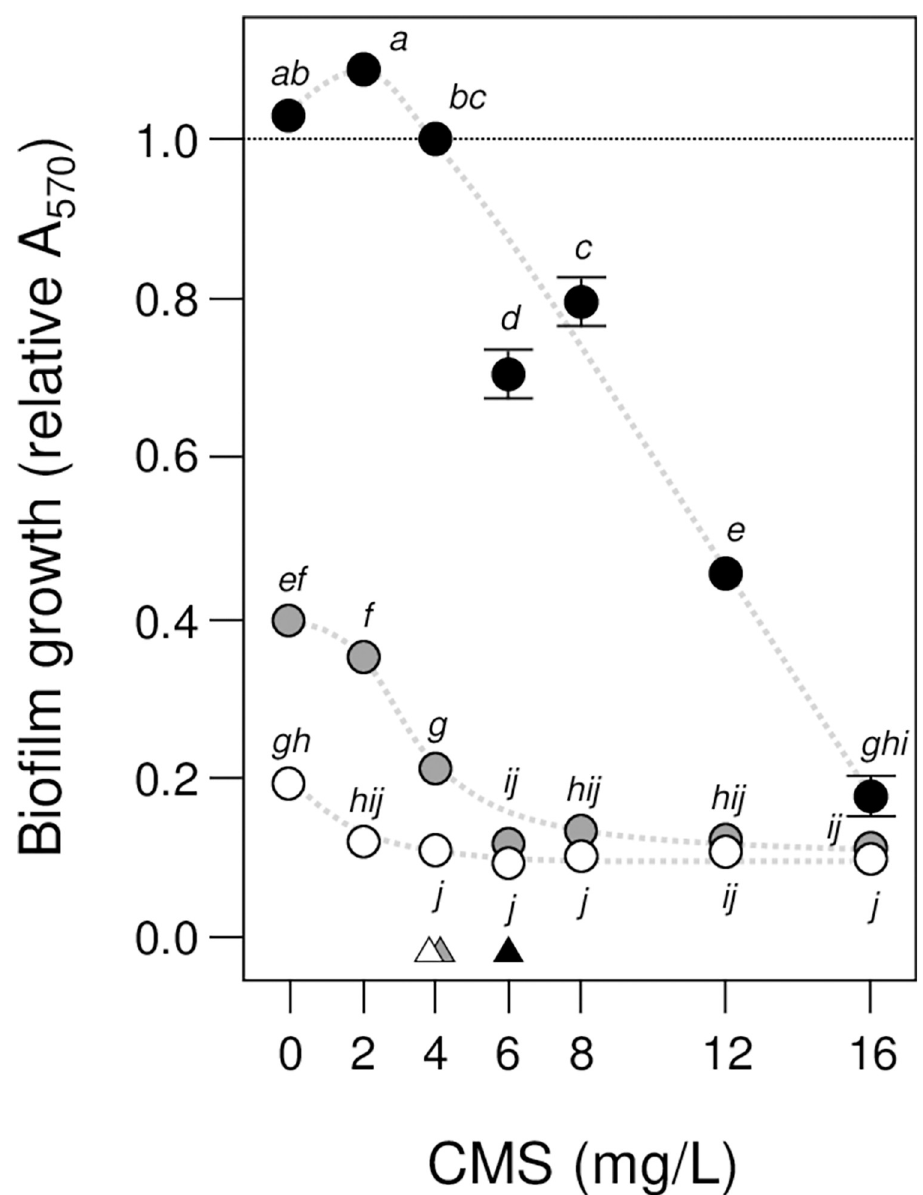
Fig 4. MTT assays of K . pneumonia biofilm growth confirms synergistic action of AZM and CMS. The effect of azithromycin (AZM) and colistin methanesulfonate (CMS) on K . pneumonia ATCC 10031 biofilm growth was investigated using the metabolic indicator dye MTT with absorbance (A 570 ) measurements after 24 h incubation. Mean relative A 570 ± SE ( n = 3) is shown, with no-AZM (control) treatments indicated by dark circles, 3 mg/L AZM by grey circles and 9 mg/L AZM by white circles (trends are suggested by dashed curves). Means not connected by the same letters are significantly different (LSMeans Differences Tukey HSD, alpha = 0.05 for mixed-effects model of relative A 570 ). Small triangles indicate planktonic and biofilm minimum inhibitory concentrations (MIC) where relative A 570 was first significantly reduced by CMS for each AZM